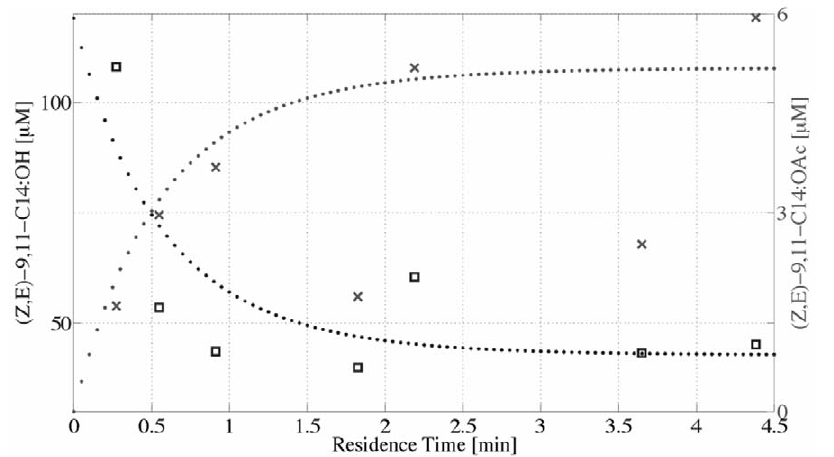
Figure 3. Scatter plot of conversion as a function of residence time in microreactor. Displayed are the concentrations of substrate (squares), product (crosses) recovered from two different microreactors with equal amounts of atf and the resulting (dashed) curves resulting from the numerical modeling. The experimental points show large scatter, probably due to uncontrolled loss of substrate or product in some experiments.